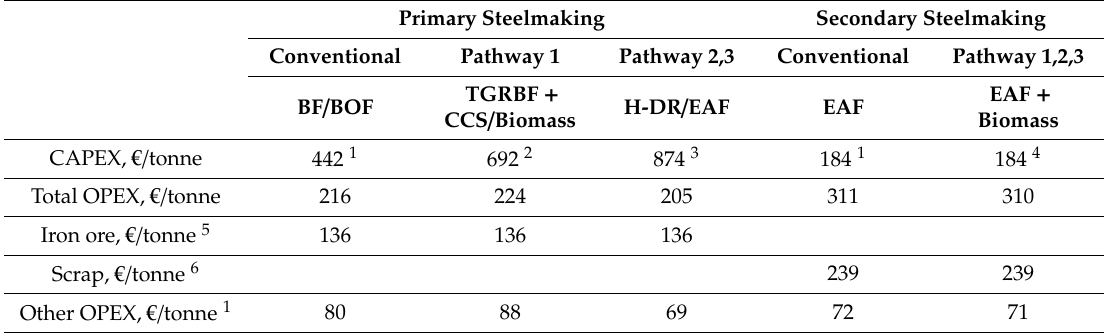
Table A3. Capital and operating expenses of steelmaking technologies for investigated